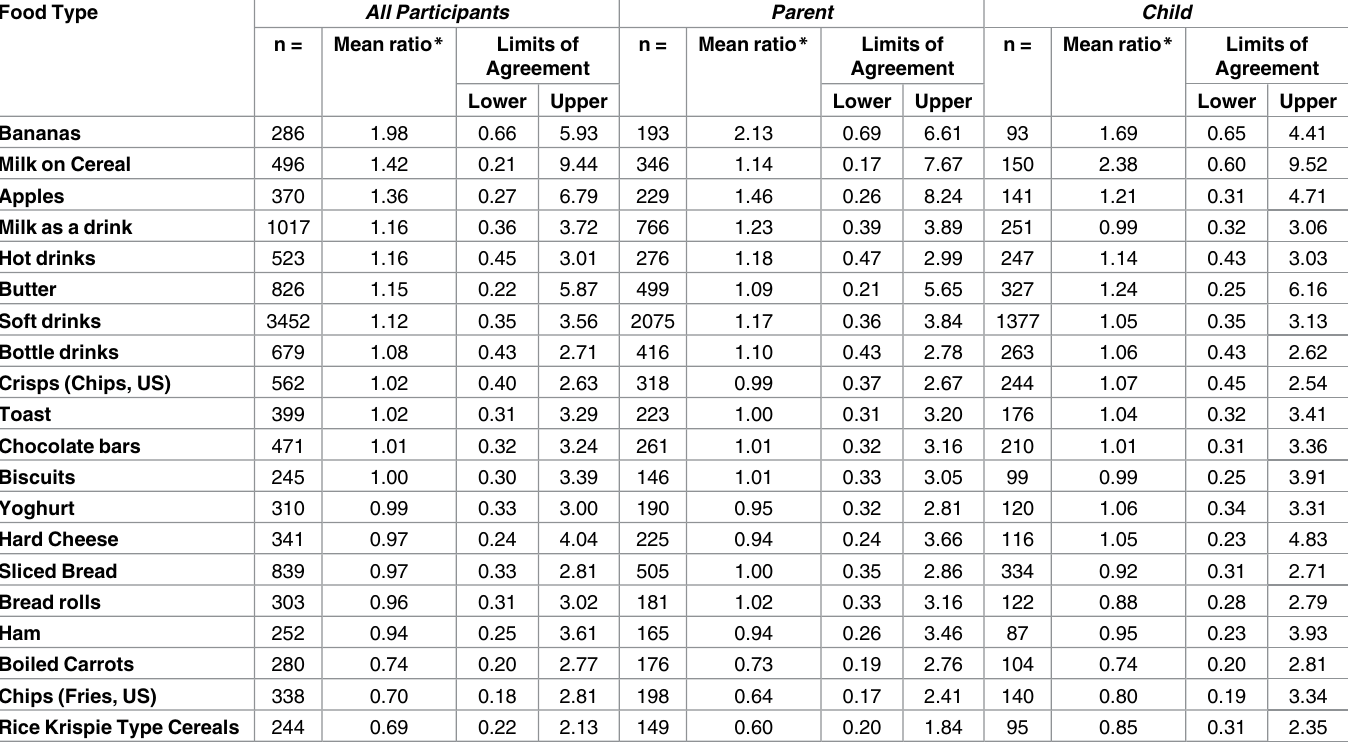
Table 4. Agreement of estimatesof portion size using YPFA with weighed food diaries—by food type.